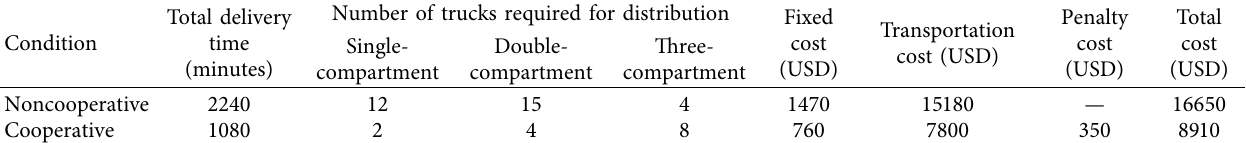
Table 4: Comparison of relative indexes of multidepot petrol distribution network in a small-scale example.